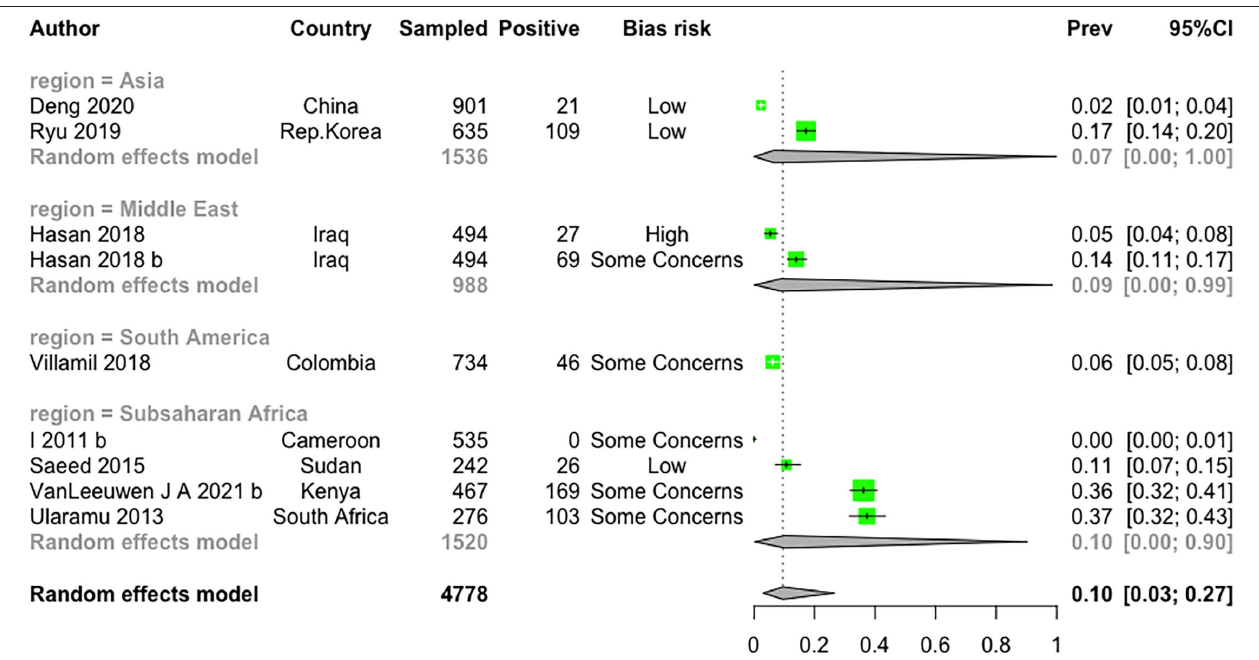
FIGURE 6 | A forest plot of the weighted meta-analysis of reported BVDV antigen prevalence by country. The plot shows the study ID, the country where the study was conducted, the sample size, the number of positive test results for BVDV, the risk of bias rank overall, the point estimate with 95% confidence interval with the box proportional to the weighting of the fixed effect, the numerical value of the point estimate of BVDV prevalence (the effect size) and the estimated 95% confidence interval (unadjusted in black, weighted adjusted in